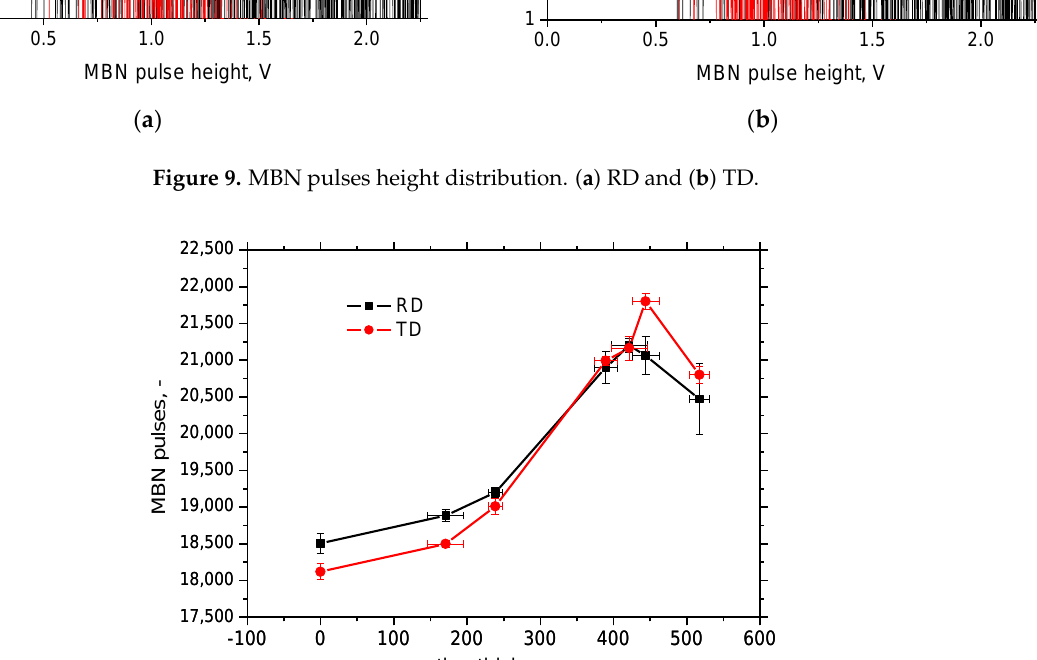
Figure 10. Coating thickness (obtained from the LM observations) versus number of MBN pulses.